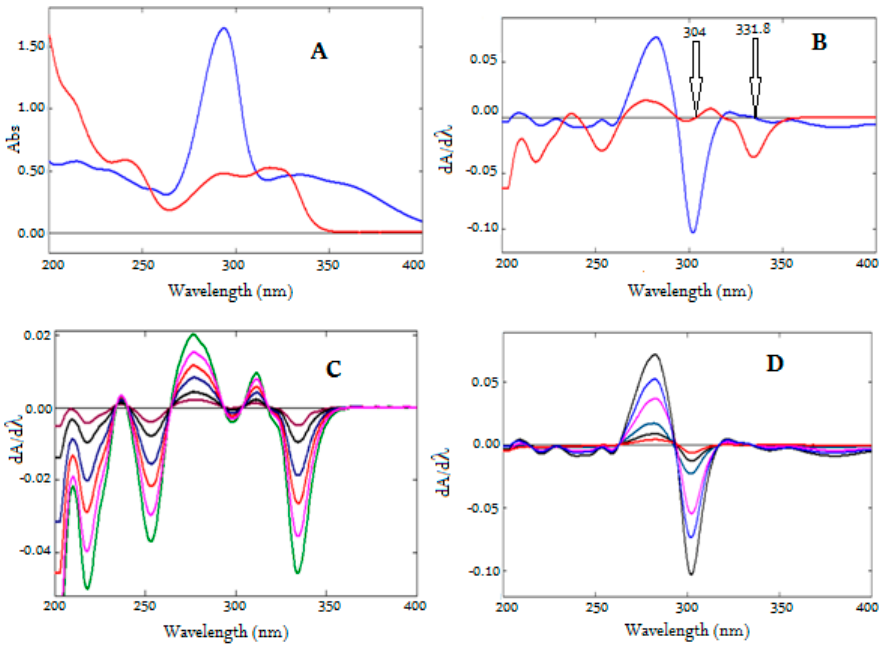
Figure 3. UV spectra of MOX and FLX ( A ), Overlain First derivative UV spectra of MOX and FLX ( B ), First derivative UV spectra of FLX ( C , 2–20 µ g/mL), First derivative UV spectra of MOX ( D , 1–16 µ g/mL).